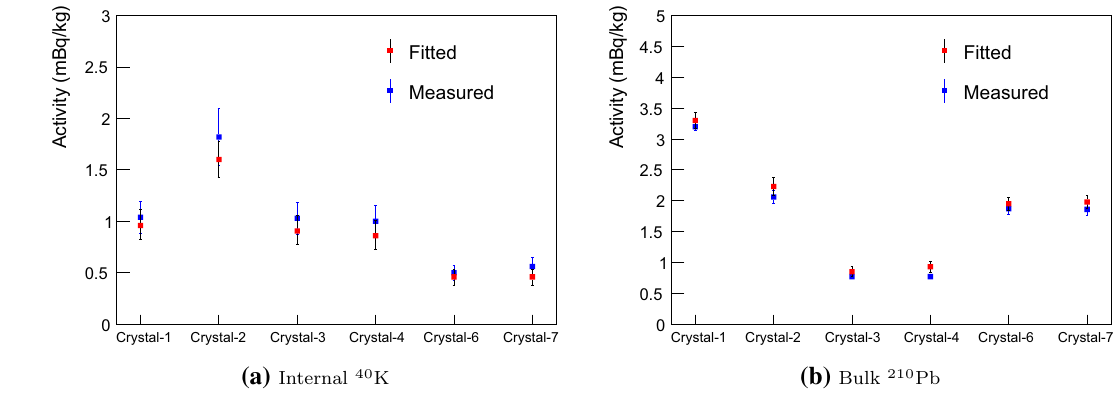
Fig. 7 Comparison of the measured and the fitted activity levels in six NaI(Tl) crystals